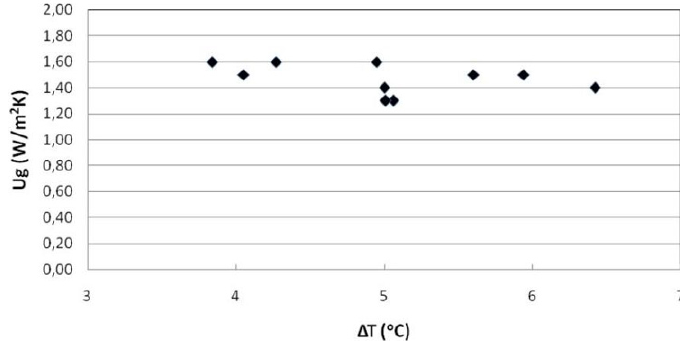
Figure 19. Variation of U g versus temperature difference ∆ T . Scenario 3